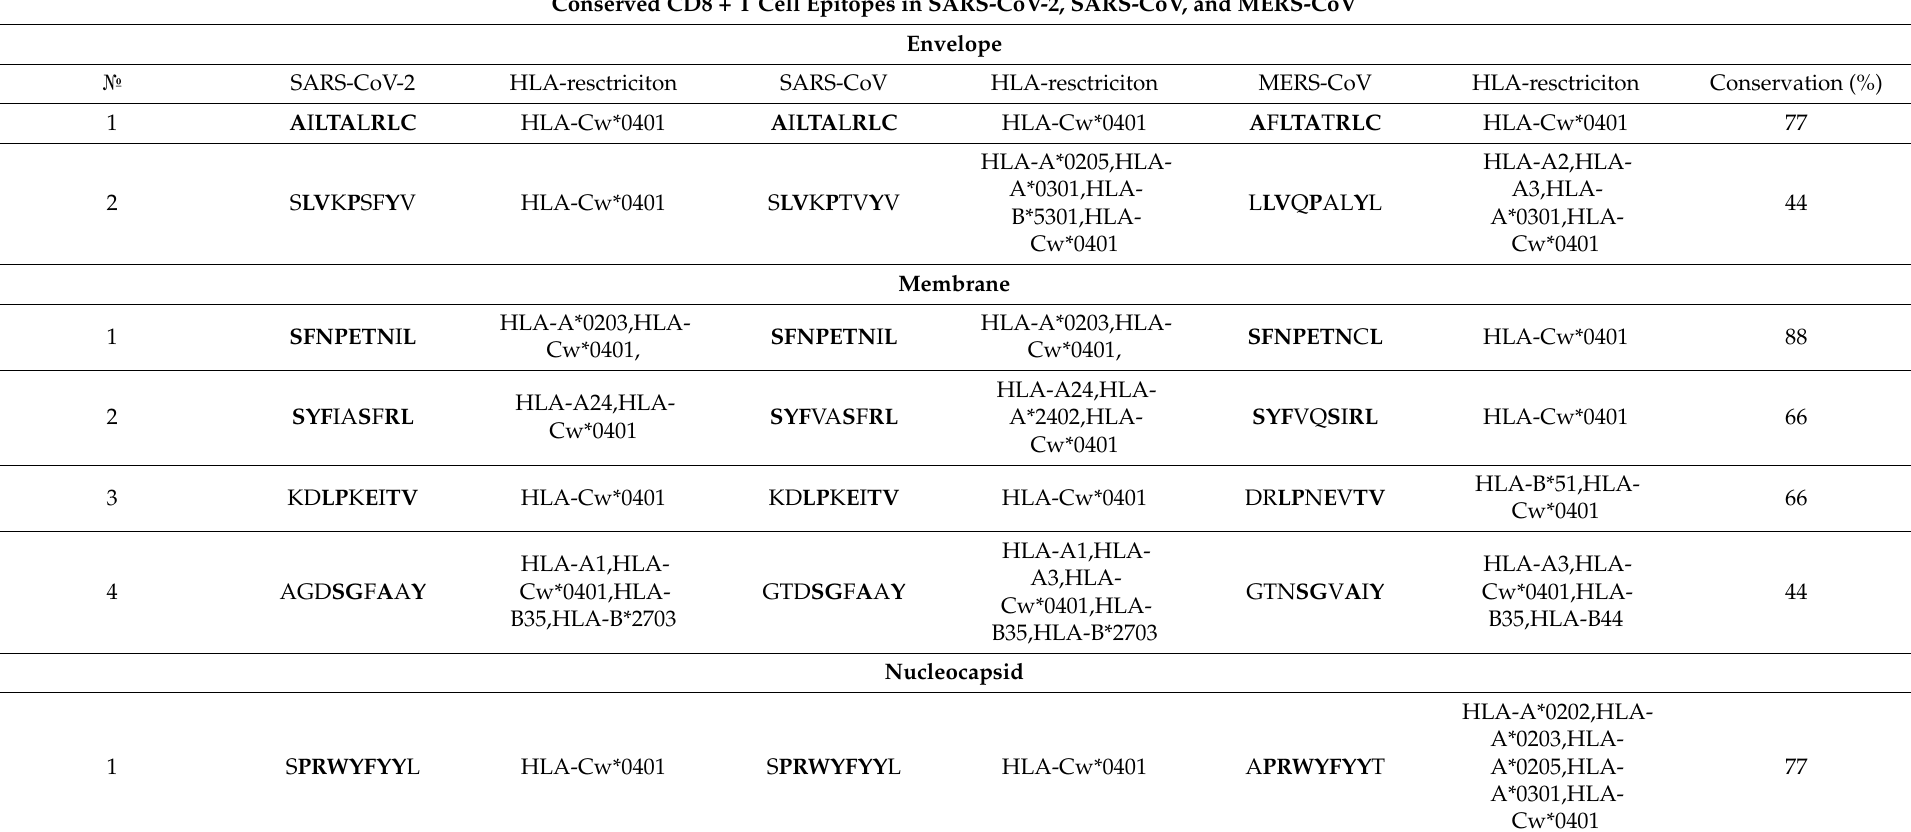
Table 3. Predicted CD8+ T cell epitopes found to be conserved SARS-CoV-2, SARS-CoV, and MERS-CoV. Conserved amino acids are shown in bold letters. HLA restriction for each epitope is also